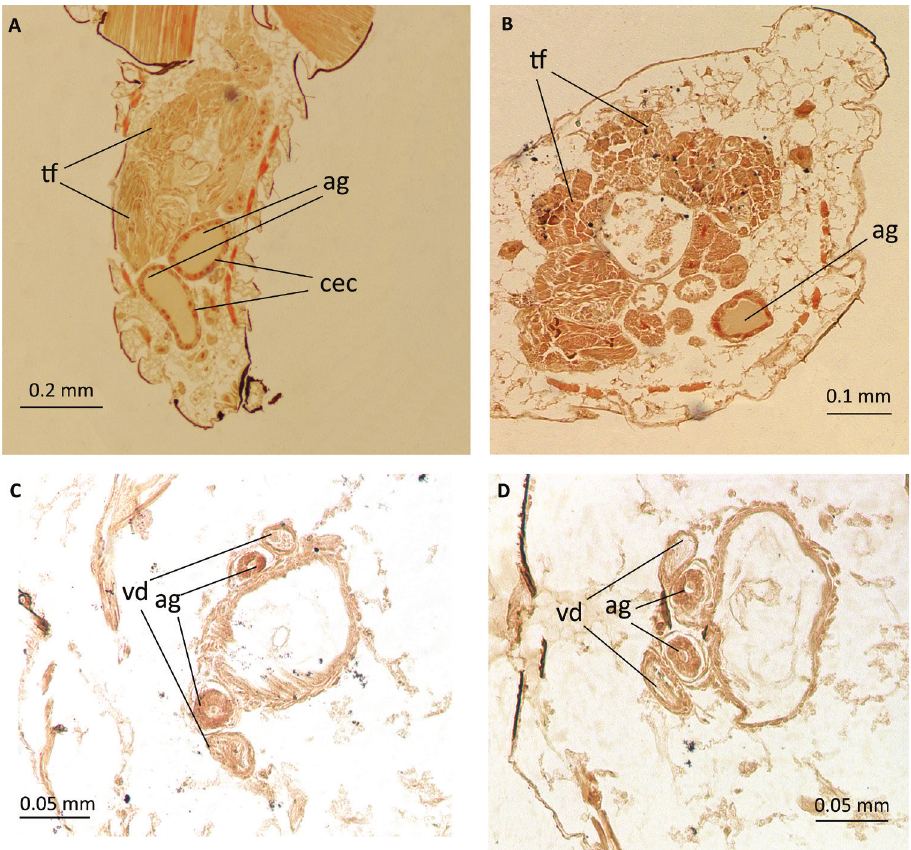
Figure 7. Male reproductive system of P. tremulae : A longitudinal section through testicles B, C, D cross sections through testicles; ag – accessory gland, cec – cuboidal epithelial cells, tf – testicular follicles, vd – vas